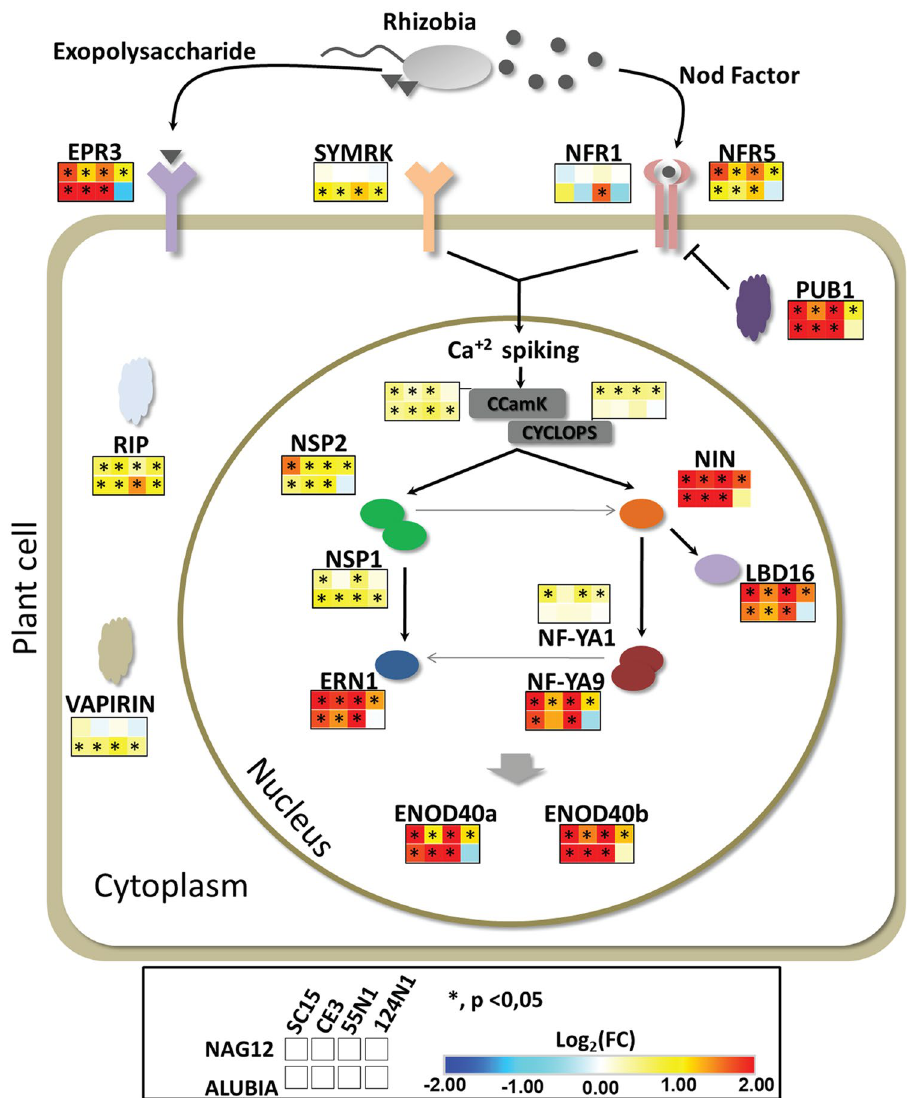
Figure 5. Expression analysis of nodulation signaling pathway components in response to different strains of R. etli . The scheme displays the main components of the nodulation signaling pathway triggered by rhizobia inoculation in root cells and their subcellular localization. The Log 2 fold change (FC) of those genes that were identified as DEGs is shown as a heat map. Squares on the upper and bottom rows show the expression pattern in NAG12 and Alubia, respectively. From left to right R. etli strains are SC15 and CE3 ( nod C-α), 55N1 and 24N1 ( nod C-δ). The asterisk (*) indicates that the transcript levels in R. etli inoculated roots were significantly different from those treated with YEM with a p value < 0.05. EPR3 (Phvul.002G059500), SYMRK (Phvul.011G148700), NFR1 (Phvul.008G211200), NFR5 (Phvul.002G025500), RIP (Phvul.008G249800), PUB1 (Phvul.008G222100), NSP2 (Phvul.009G122700), ERN1 (Phvul.001G111800), NIN (Phvul.009G115800), LBD16 (Phvul.001G159300), NF-YA9 (Phvul.007G267100), NF-YA1 (Phvul.001G196800), ENOD40a (Phvul.002G064232), ENOD40b (Phvul.002G064166), VAPIRIN (Phvul.001G113900), CCaMK (Phvul.011G186900), CYCLOPS